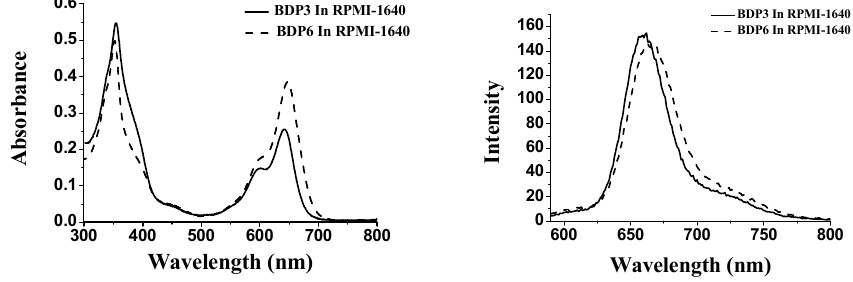
Figure 4. Electronic absorption ( left ) and Fluorescence emission spectra ( right ) of BDP3 and BDP6 , formulated with Cremophor EL (0.05%) in the RPMI 1640 culture medium (all at 10 µM).